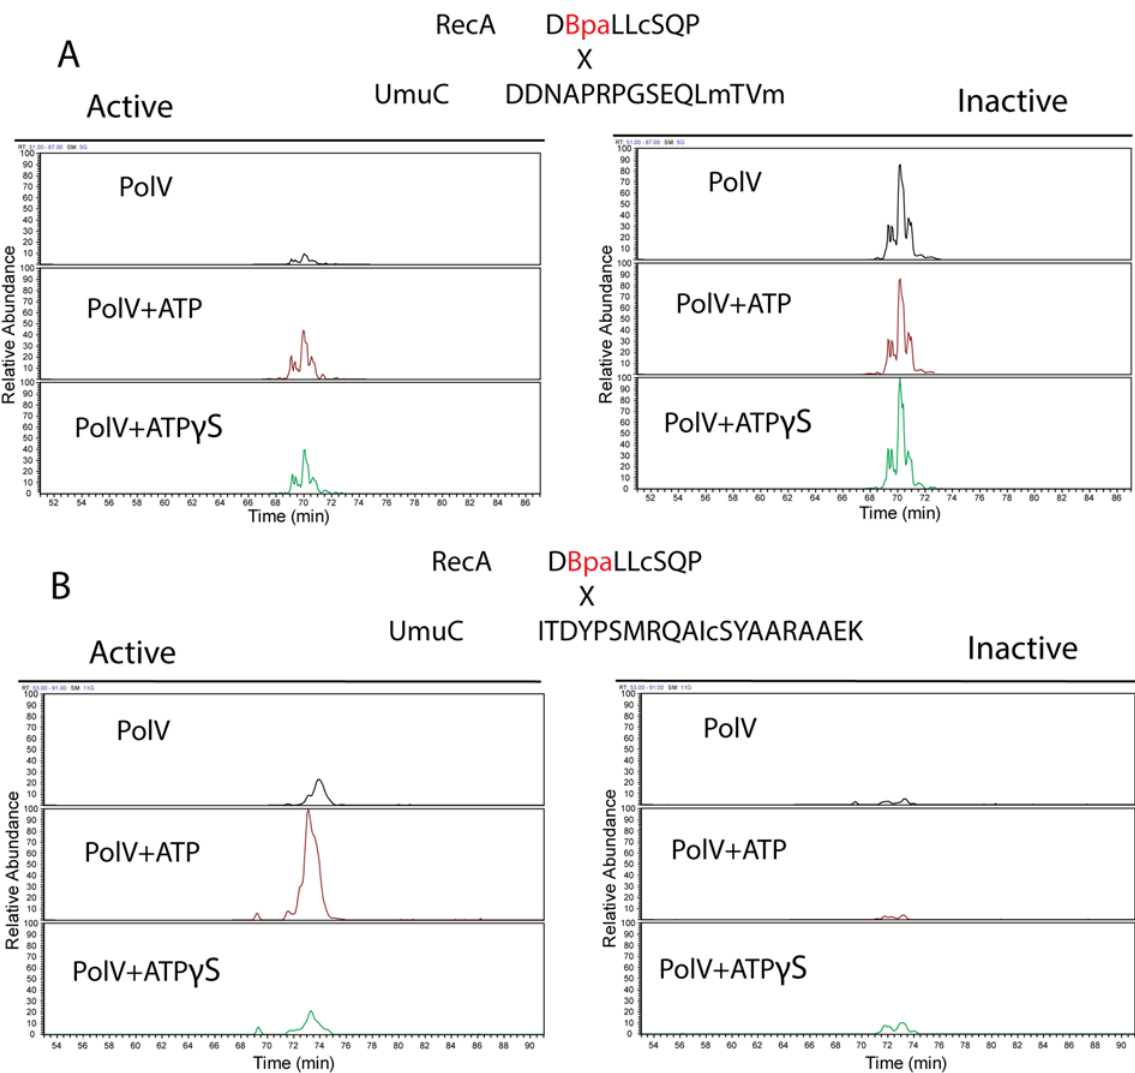
Fig 12. Extracted Ion Chromatograms for the RecA-UmuC cross-linked peptides. (A) Cross-linked product #1. This was the most prominent cross- linked product and was found in virtually all samples generated with either of the two protocols (active or inactive). The product appeared to be somewhat more prominent in the inactive samples. (B) Cross-linked product #2. This product was more prominent in the active samples. Signal intensity was normalized to the highest for each unique peptide pair within a panel (A or B). However, the panel scales are different. Peaks in panel B are approximately 10 fold less prominent than those in panel